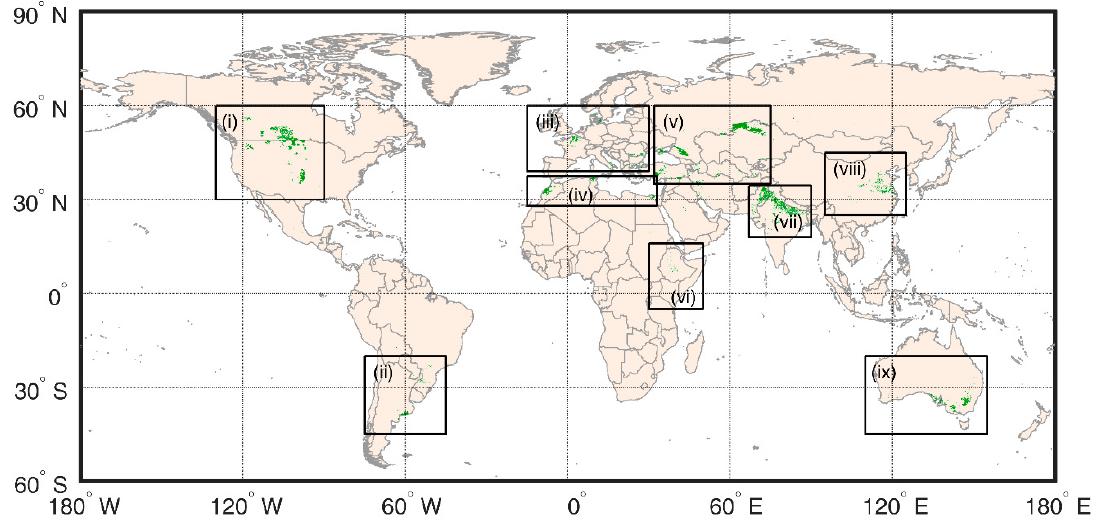
Figure 1. Global wheat (green dots) distribution map. ( i )–( ix ) represent the nine major wheat-planting regions, i.e., North America, South America, Europe, North Africa, Central-West Asia, East Africa, South Asia, China, and Australia.